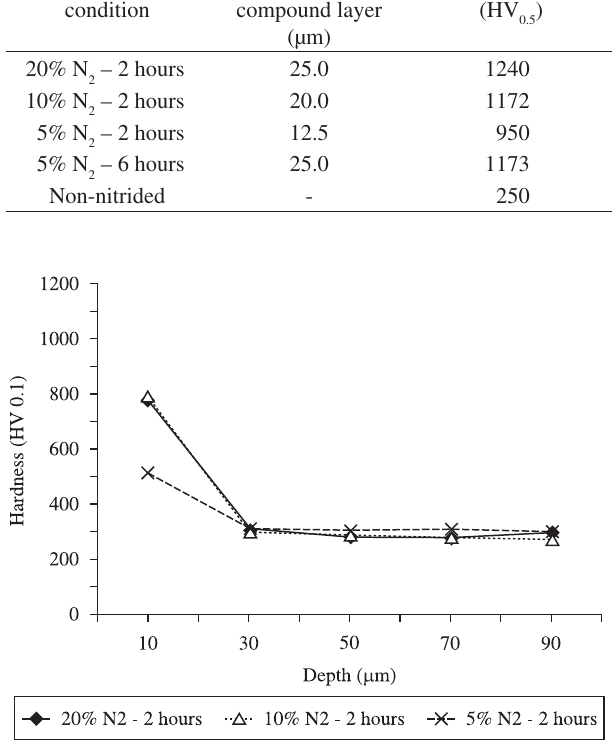
Figure 4. Hardness profiles of processed samples as a function of the nitriding